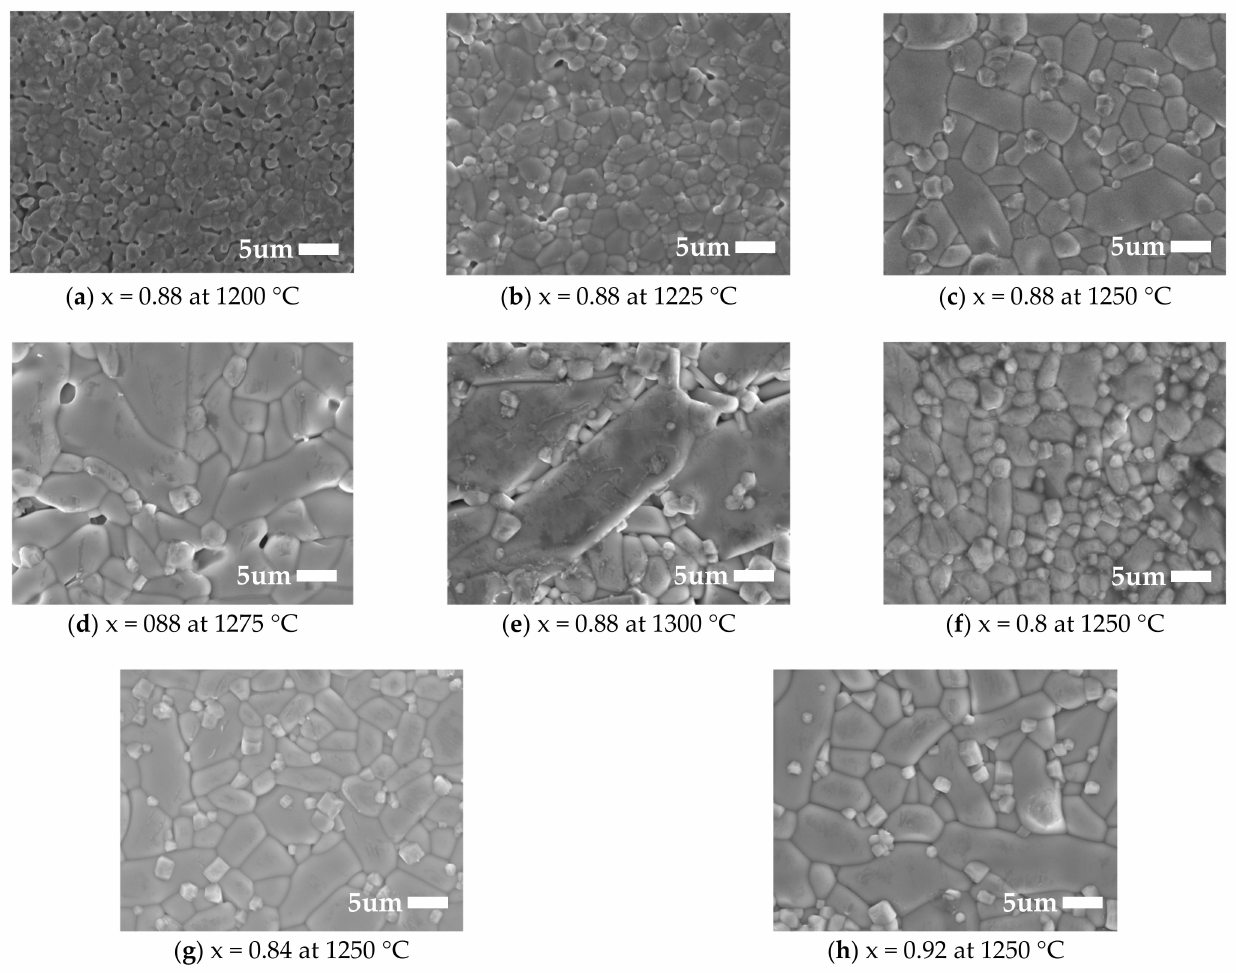
Figure 4. ( a – h ) Scanning electron microscopy photographs of Ca 0.8 Sm 0.4/3 TiO 3 -modified (Mg 0.6 Zn 0.4 ) 0.95 Ni 0.05 TiO 3 with x = 0.88 sintered from 1200 ◦ C to 1300 ◦ C for 4 h and with various x values sintered at 1250 ◦ C for 4 h. Individual grain composition and distribution in the 0.88MZNT-0.12CLa/CSm ceram- ics sintered at 1225 ◦ C (Ca 0.6 La 0.8/3 TiO 3 )/1250 ◦ C (Ca 0.8 Sm 0.4/3 TiO 3 ) were checked by EDS and the backscattered electronic image (BEI) as shown in Figure 5. The grains marked with spots A–J can be divided into three groups: huge dark grey polygons (spots A and C, and spots F and G), small bright grey polygons (spots D and E, and spots I and J), and small dark grey stick (spot B, and H). Huge polygons were distinguished as (Mg 0.6 Zn 0.4 ) 0.95 Ni 0.05 TiO 3 accompanying small polygons Ca 0.8 Sm 0.4/3 TiO 3 or Ca 0.6 La 0.8/3 TiO 3 crystallites nearby. The distributed small stick was indexed as (Mg 0.6 Zn 0.4 ) 0.95 Ni 0.05 Ti 2 O 5 , which is not a dom- inant element in the specimen. As expected, xMZNT-(1 − x)CLa/CSm phases separated since they exhibited virtually no solubility between them due to different crystal structures. This discussion was further confirmed in BEI